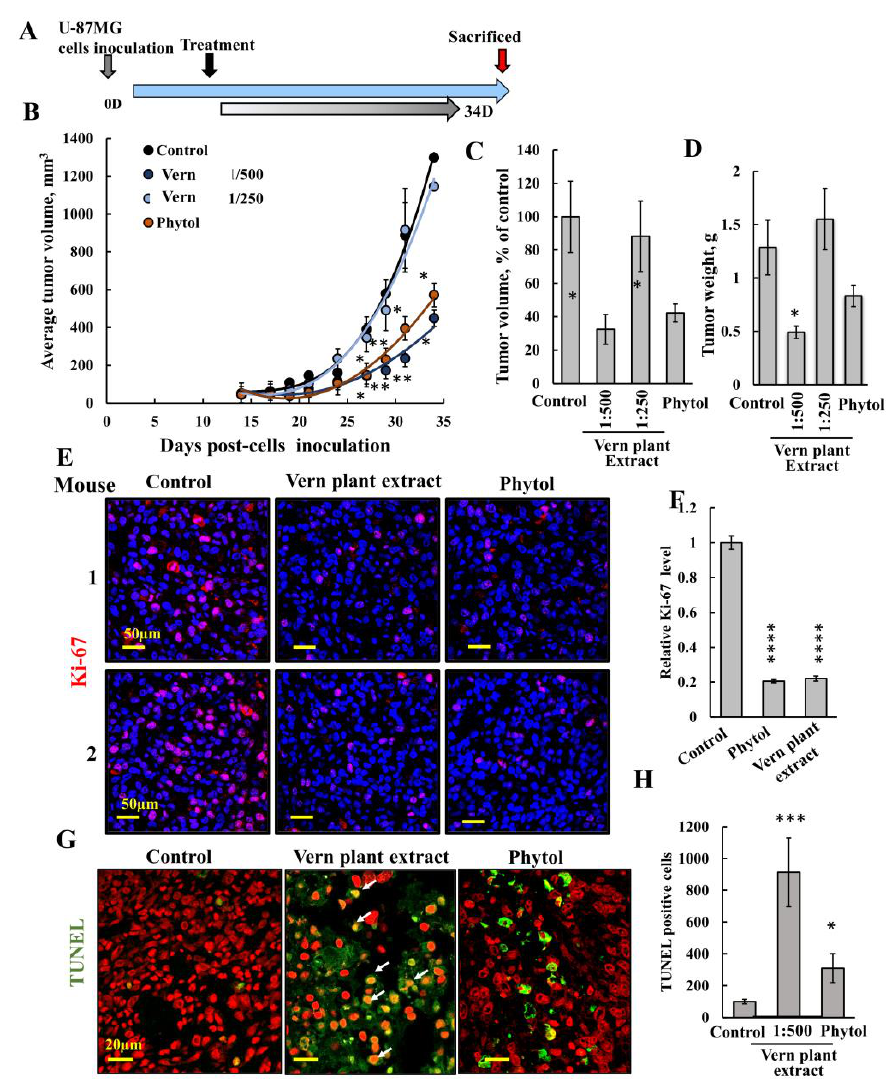
Figure 6. Inhibition of tumor growth by Vern plant extract and phytol in a GBM xenograft mouse model. U-87MG cells (1.8 × 10 6 cells/mouse) were s.c. inoculated into nude mice. Tumor volume was